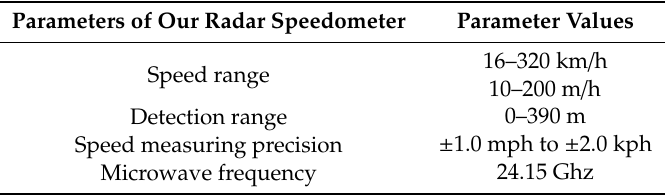
Table 3. Main technical parameters of the speed gun.